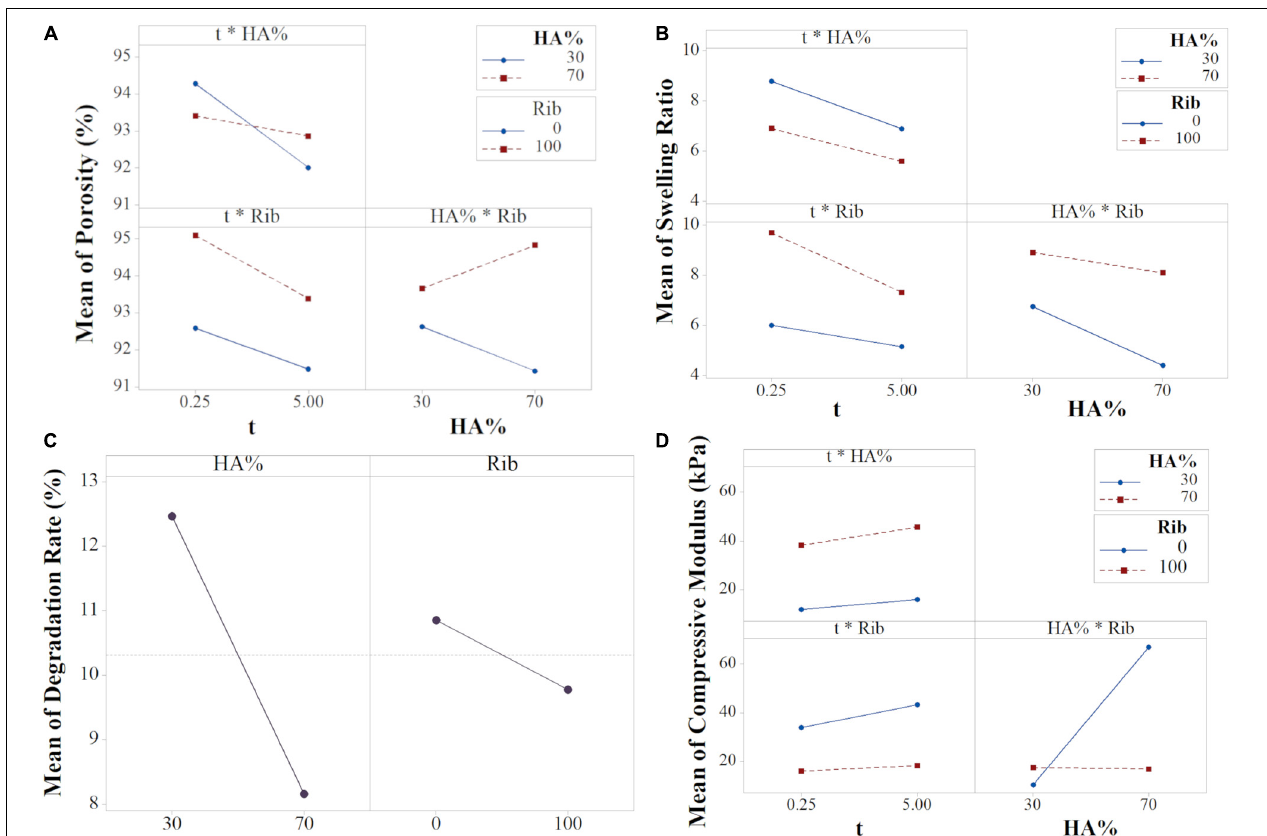
FIGURE 7 | Interaction plots for (A) Porosity, (B) Swelling Ratio, (D) Compressive Modulus, and (C) Main plot for Degradation (data from the reduced